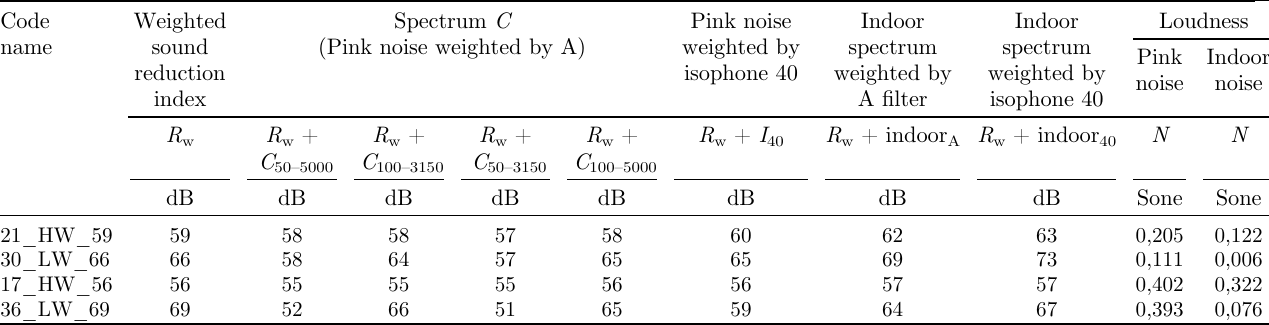
Table A1. Selection of the walls of which the spectra are depicted in Figure A1, and their properties. Code